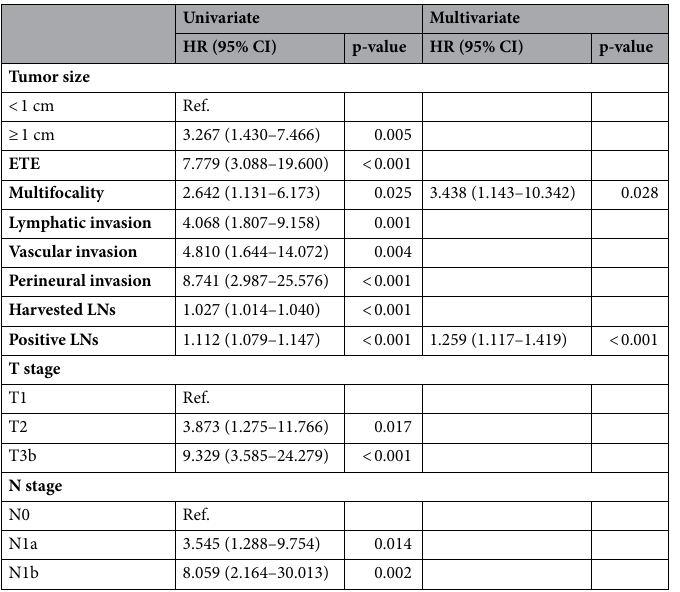
Table 7. Univariate and multivariate analyses of risk factors for recurrence in patients aged > 45 years after propensity score matching. Data are expressed as hazard ratio (HR) and 95% confidence interval (CI). A p value < 0.05 was considered statistically significant. ETE extrathyroidal extension, LN lymph node, N